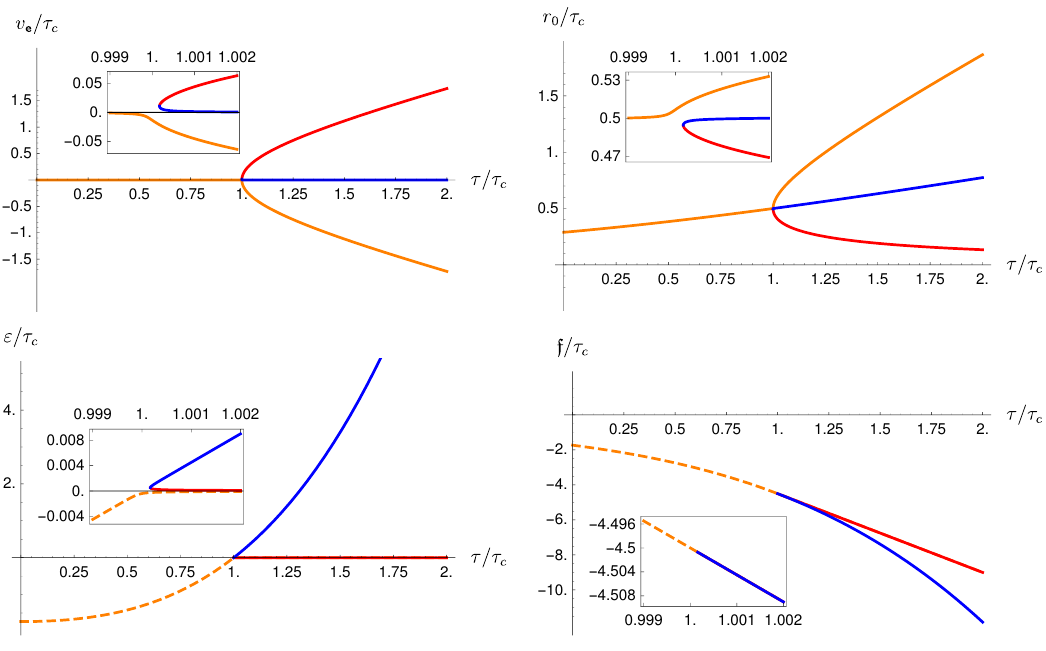
Figure 2 . Plot of the solutions of (6.16) for (cid:26) = 0 : 003 (cid:26) c , together with the corresponding energy " and Helmholtz free energy f densities. Notice that the solutions look identical to the perturbative ones in (cid:12)gure 2 for the same charge density, but zooming in near the critical temperature shows that the exact solutions are in fact